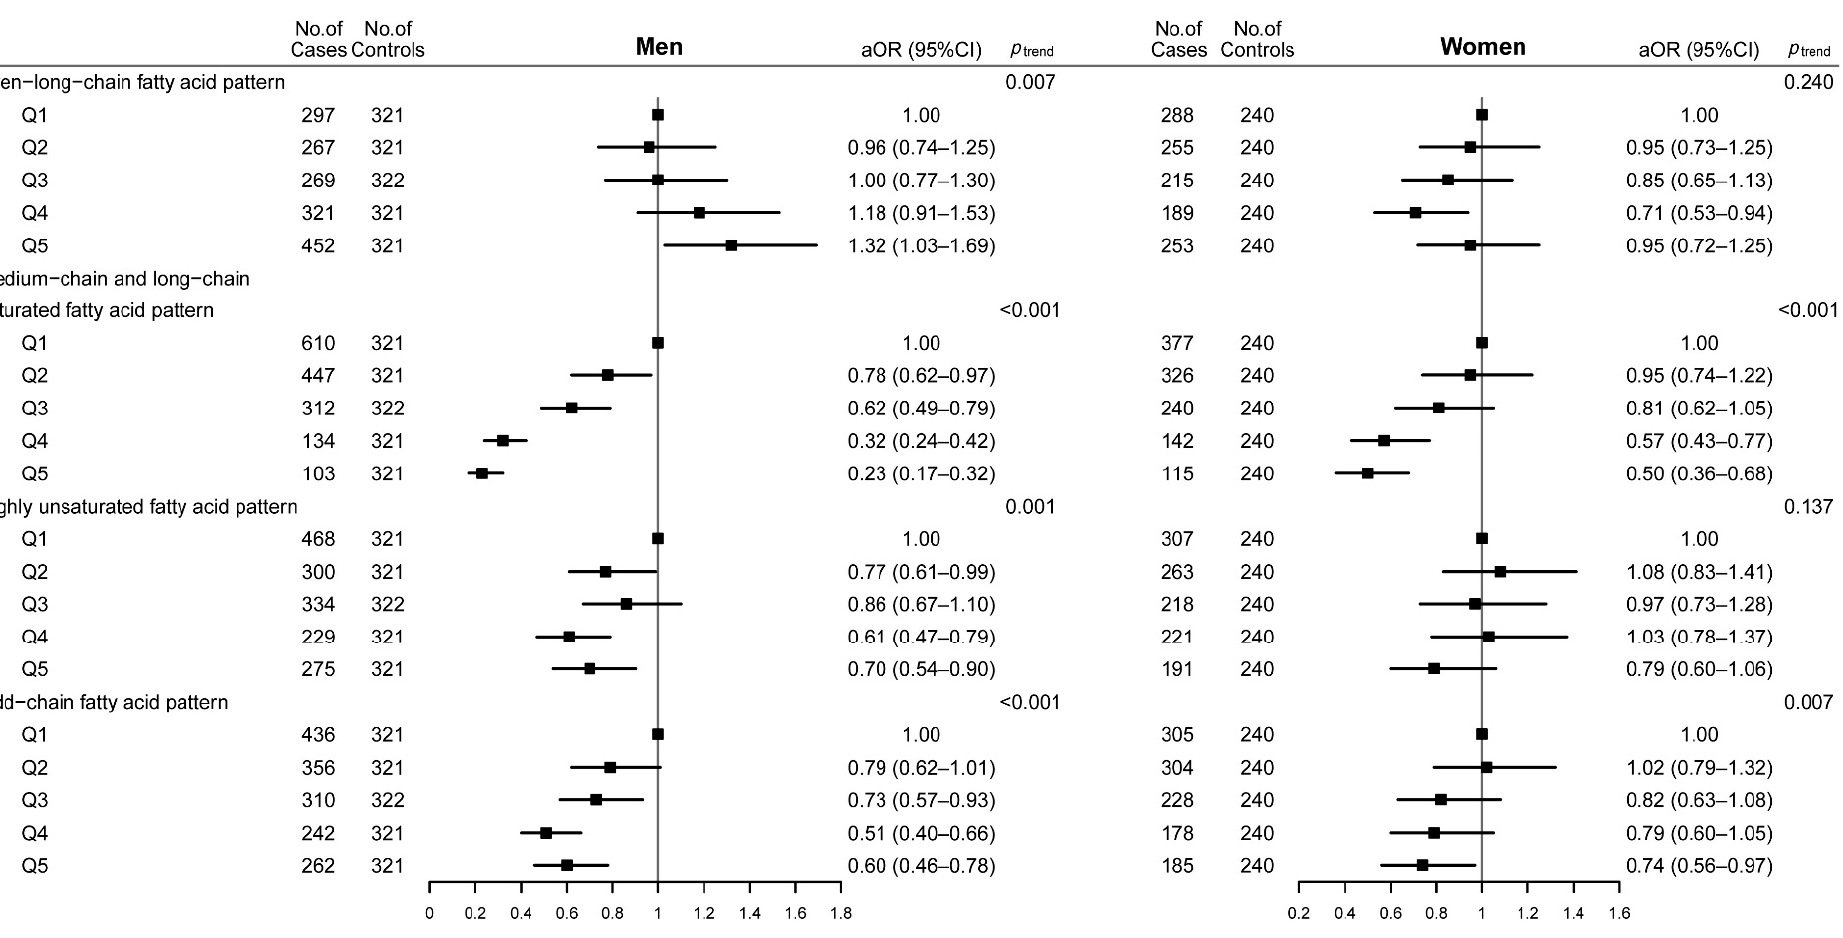
Figure 2. Adjusted odds ratios and 95% confidence intervals of colorectal cancer across quintiles of dietary fatty acid patterns according to sex. Abbreviations: Q, quintile; Q1–Q5 means the lowest quintile to the highest quintile. aOR, adjusted odds ratio; CI, confidence interval. Adjusted confounding variables included age (years), marital status, residence, education, occupation, income, occupational activity, MET, BMI, smoking and drinking status, history of cancer in first-degree relatives, and daily intakes of energy, vegetables, and fruits. The value of p for trend was calculated by placing Q1–Q5 as a continuous variable in the regression